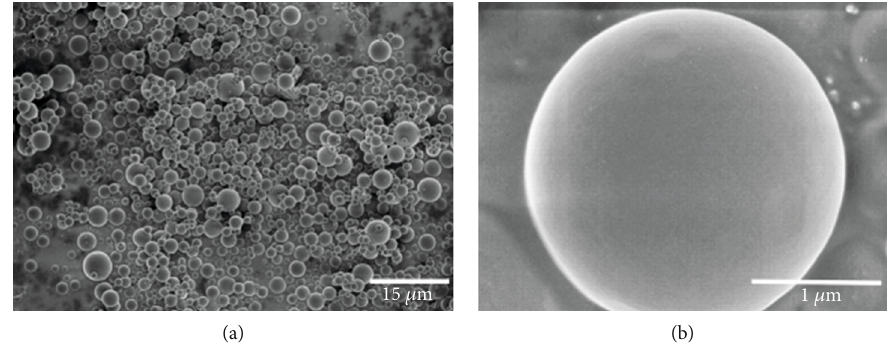
Figure 1: SEM images of CPEI (a) microsphere aggregates; (b) zoom-in image of an intact microsphere.